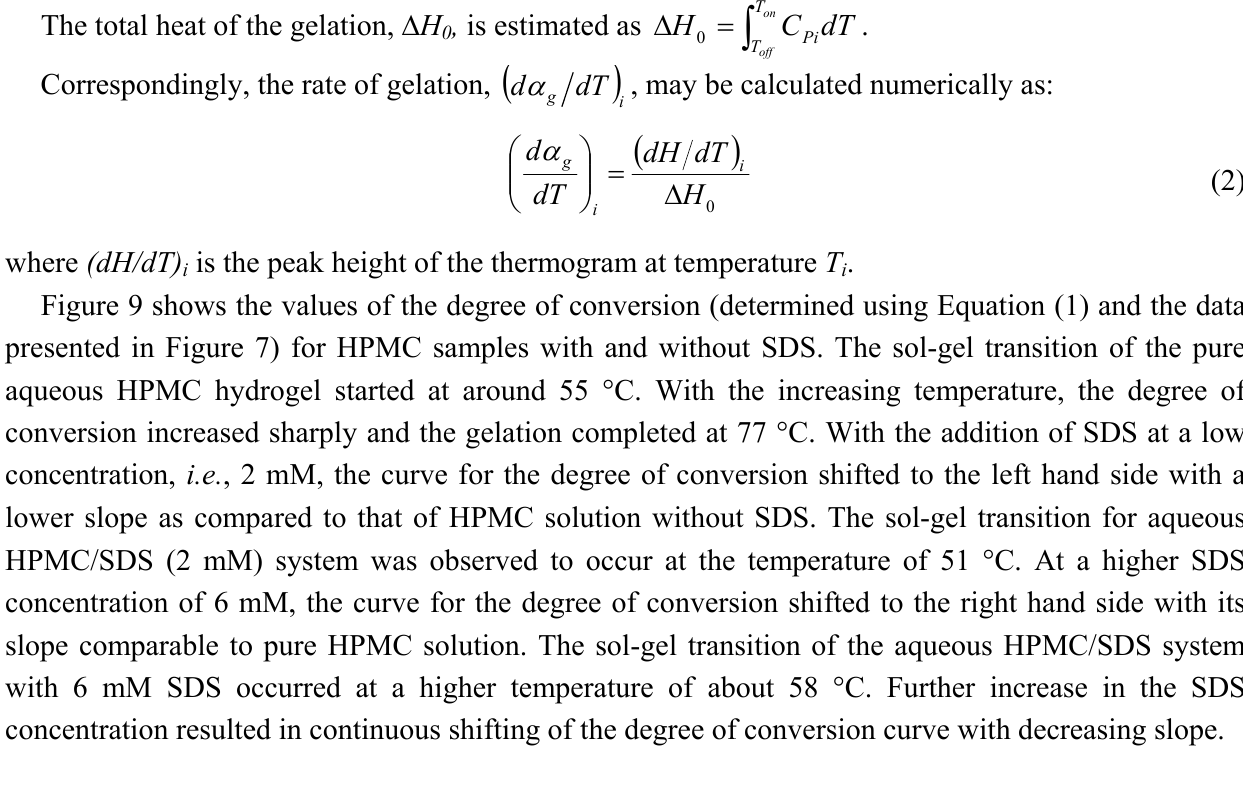
Figure 9. Effect of SDS on the gelation of 1.0 wt% HPMC